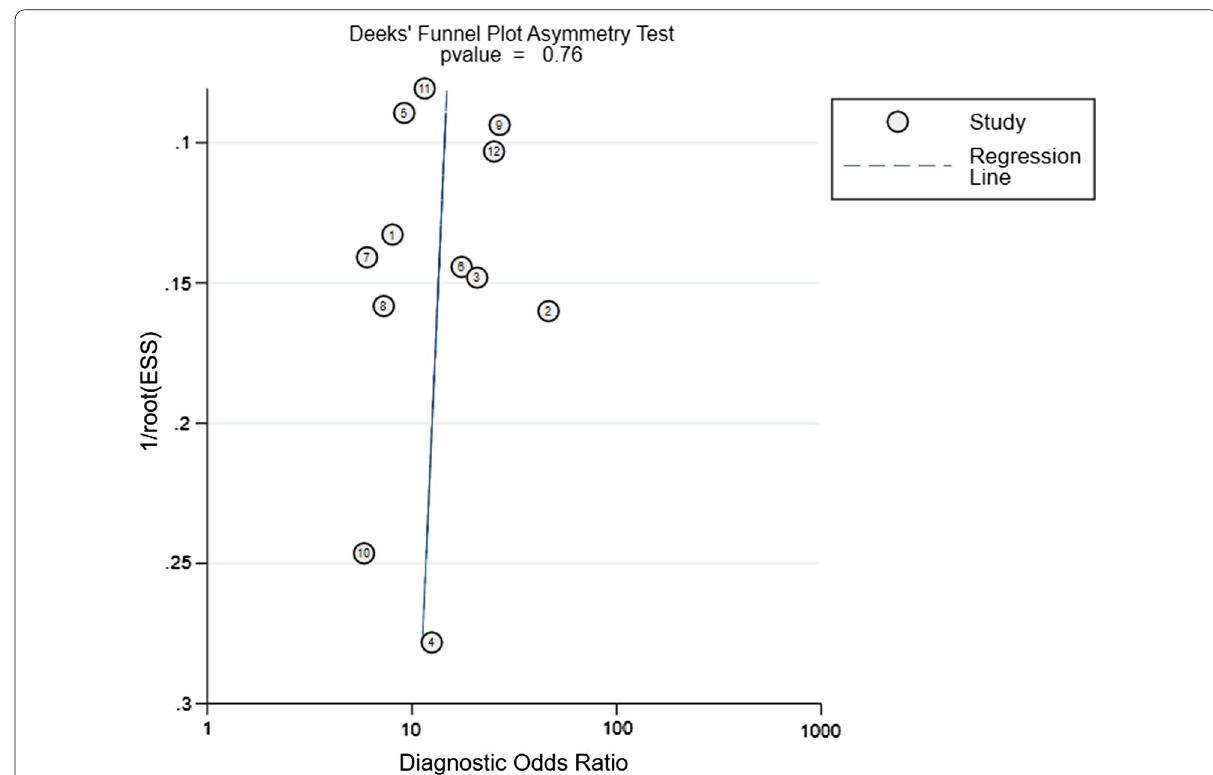
Fig. 6 The Deeks funnel plot asymmetry test to determine publication bias in the literature evaluation ( p publication bias. Each dot represents an individual